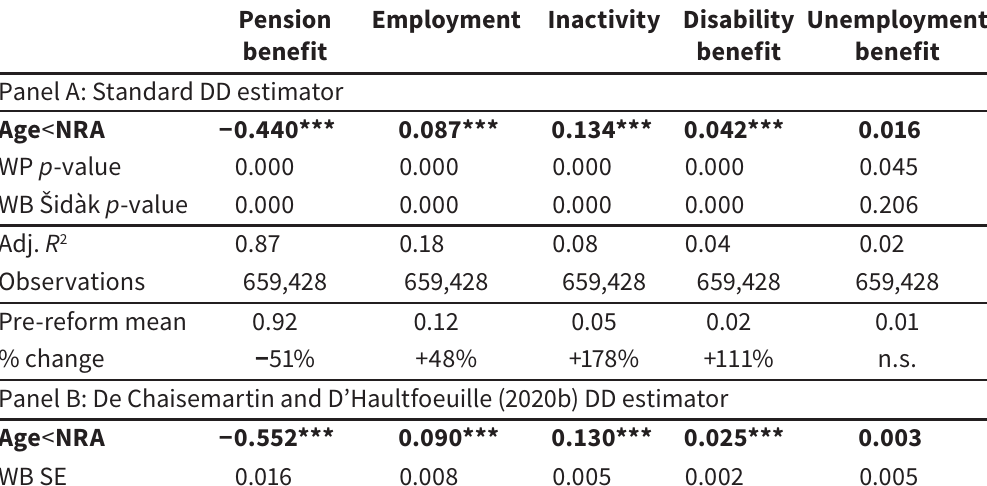
Unemployment benefit